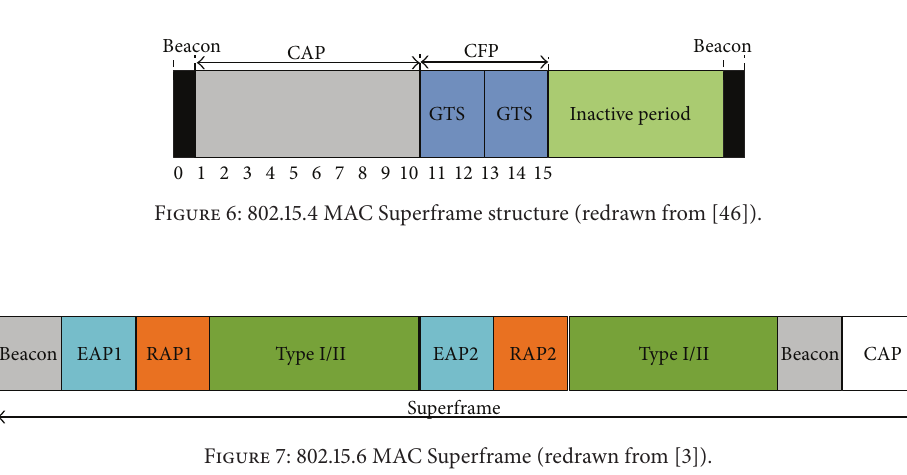
Figure 7: 802.15.6 MAC Superframe (redrawn from